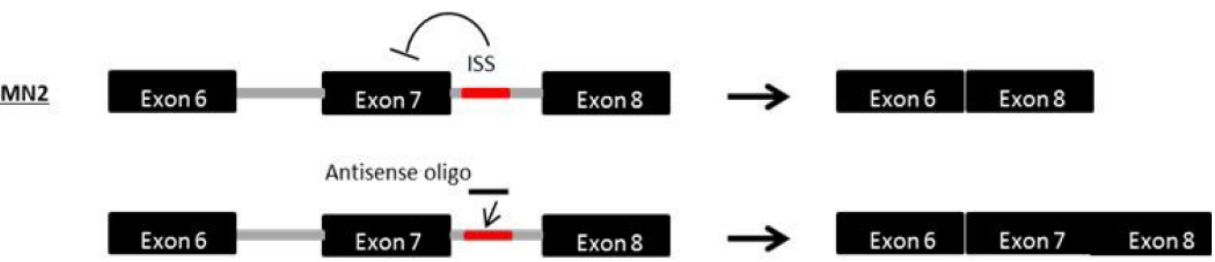
Figure 5. Mechanism of antisense exon 7 inclusion in SMN2 . Spinal muscular atrophy a paralogue of SMN1 , a single nucleotide substitution in exon 7 interferes with an